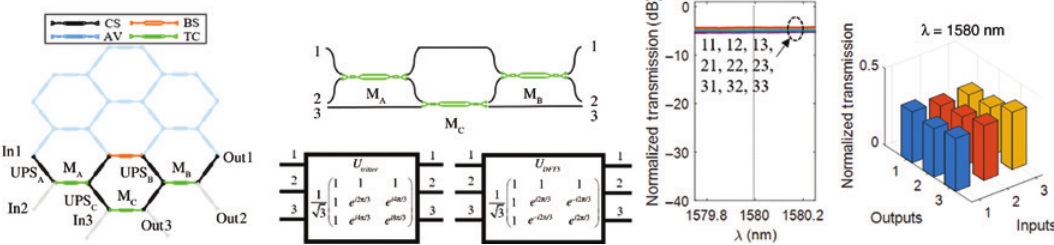
Figure 15: Unitary transformation configuration of a 3 × 3 interferometer based on a rectangular arrangement. Left column: 7-cell configuration (CS = TBU in cross state, BS = MZI in bar state, TC = TBU in tunable coupler state, AV = TBU not employed); central-left column: circuit layout of the implemented interferometer; central-right column: spectral measurement of all input/output port connections; right column: normalized bar diagram of the resulting unitary matrix for λ = 1580 nm (after Ref.